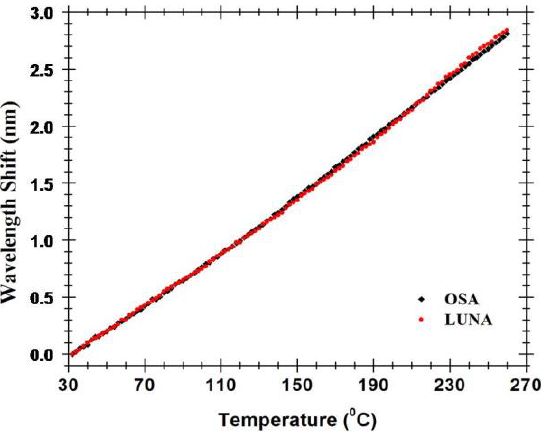
Figure 6. Wavelength shift of the hybrid low finesse Fabry-Pérot interferometer with the